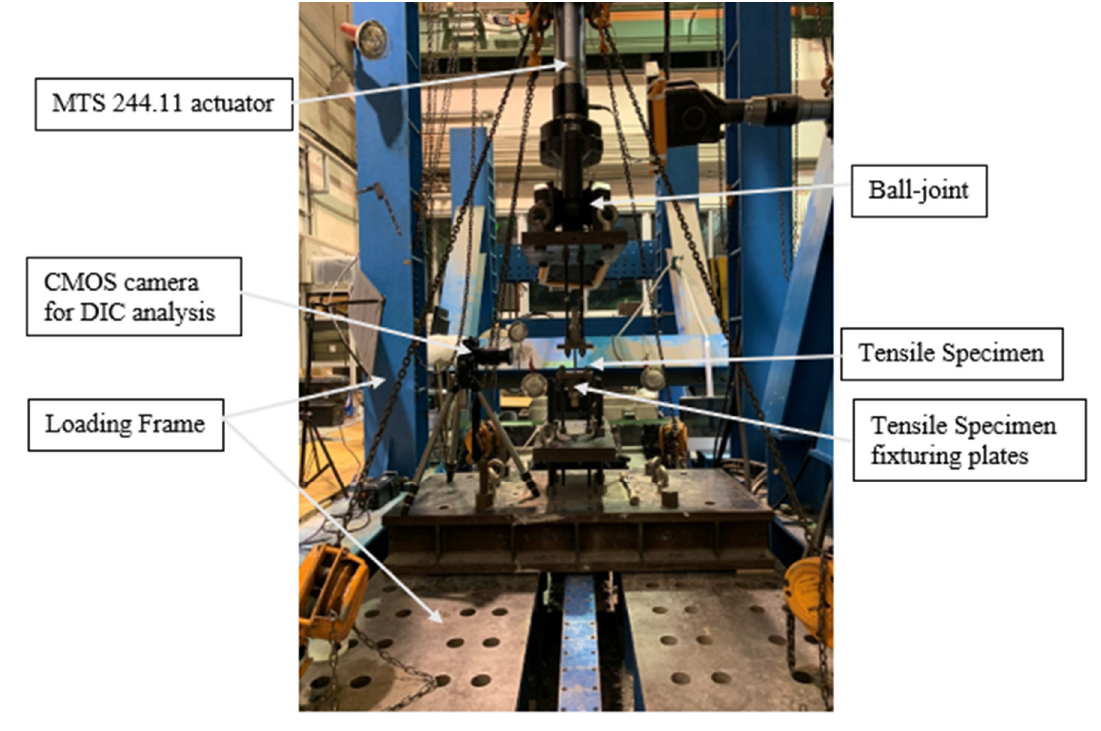
Figure 3. Experimental setup. Table 2. Manufactured specimen specifications and testing parameters (C—static; D—dynamic _strain rate_notch radius).